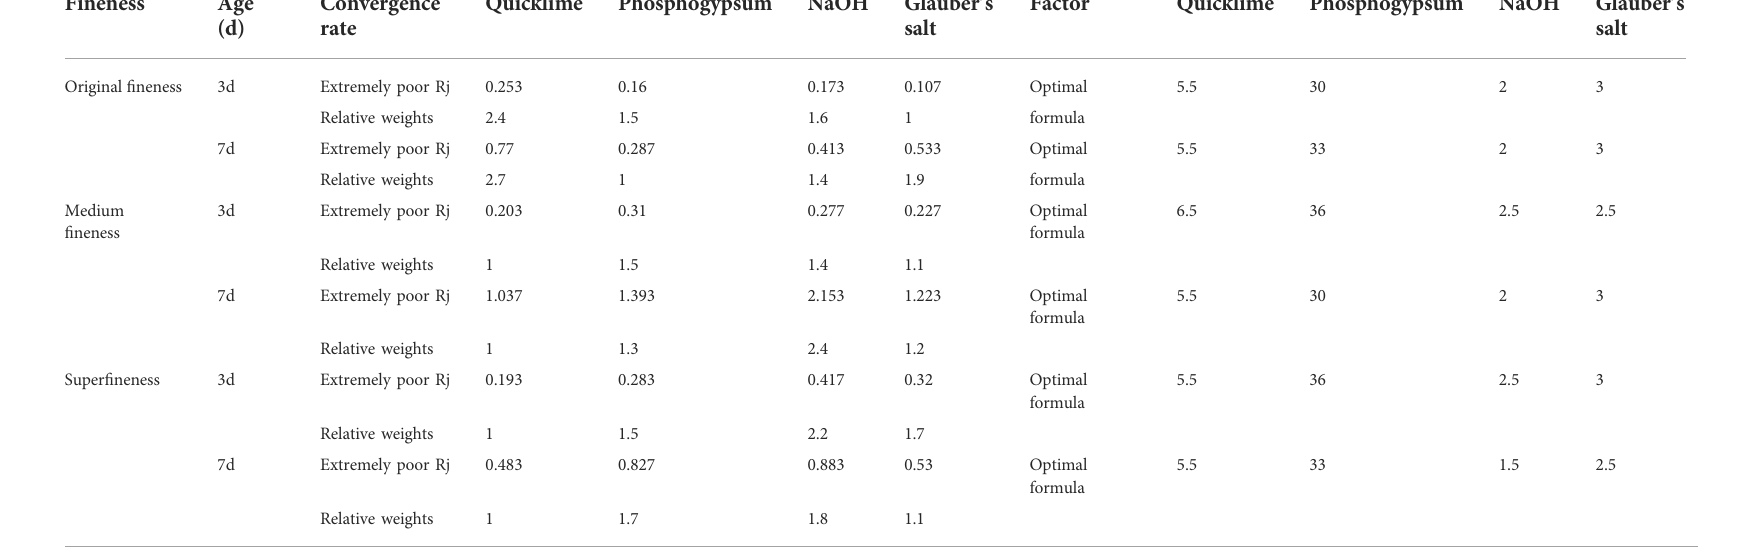
TABLE 2 Orthogonal test range analysis results.